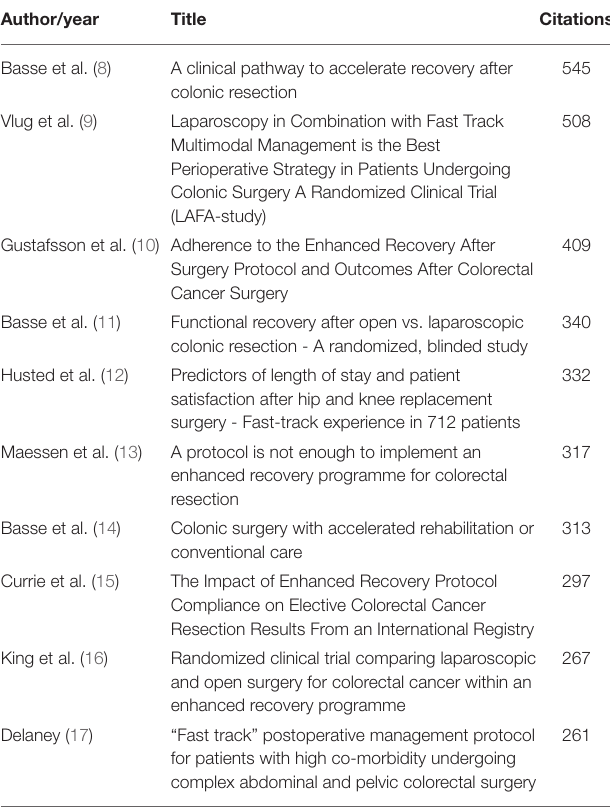
TABLE 5 | The top 10 most cited